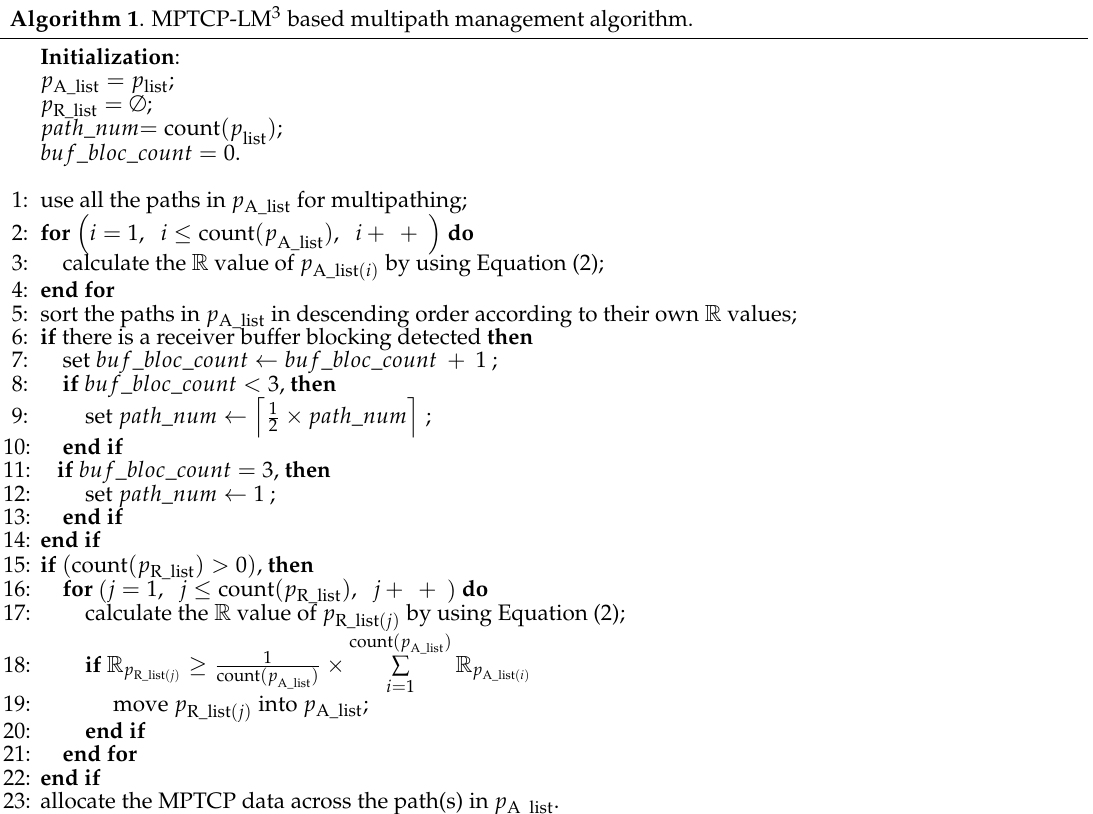
Algorithm 1 . MPTCP-LM 3 based multipath management